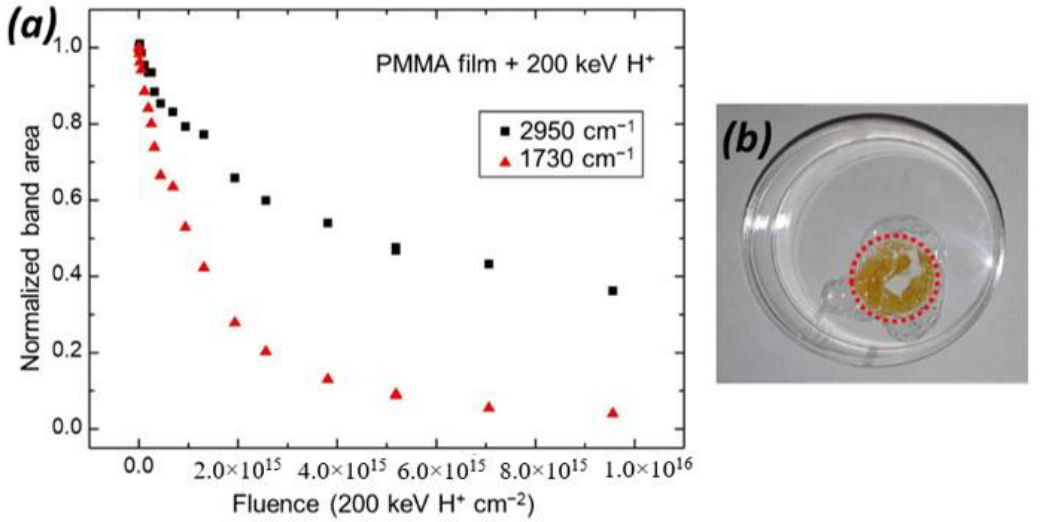
Figure 6. ( a ) Variation of the normalized band area of -CH stretching (underlying area of the peak at 2950 cm − 1 , black) and C=O stretching signal (underlying area of the peak at 1730 cm − 1 , red) as a function of ion fluence. ( b ) Picture of PMMA thin film after the ion-beam irradiation. The red circle indicates the bombarded area.